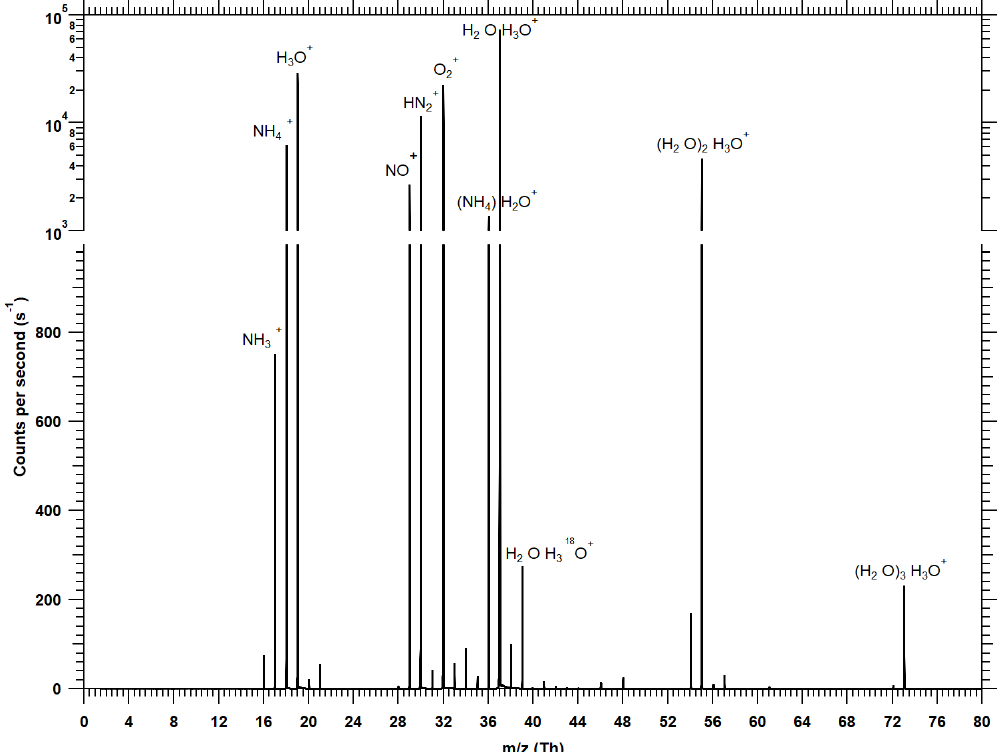
Figure 2. Typical mass spectrum recorded with the water cluster CI-APi-TOF when about 10ppbv of ammonia is added during a calibration. Signals below 1000 counts per second are shown on a linear scale, while the dominant signals (>1000cps) are shown on a logarithmic scale. To calculate the ammonia mixing ratio, the product ion signals (NH + and (H 2 O)NH + ) are normalized against the most prominent 4 4 reagent ion signals (H 3 O + , (H 2 O)H 3 O + , (H 2 O ) 2 H 3 O + , (H 2 O) 3 H 3 O + ). Larger water clusters are probably also present in the ion–molecule reaction zone, but a significant fraction of water evaporates upon crossing the pinhole at the atmospheric pressure interface of the instrument. Background peaks from N 2 H + , NO + and O + are always present but are neglected in the data evaluation. Due to the short reaction time 2 (<1ms) in the ion–molecule reaction zone, the count rates of the reagent ions dominate the spectrum even at high ammonia mixing ratios near